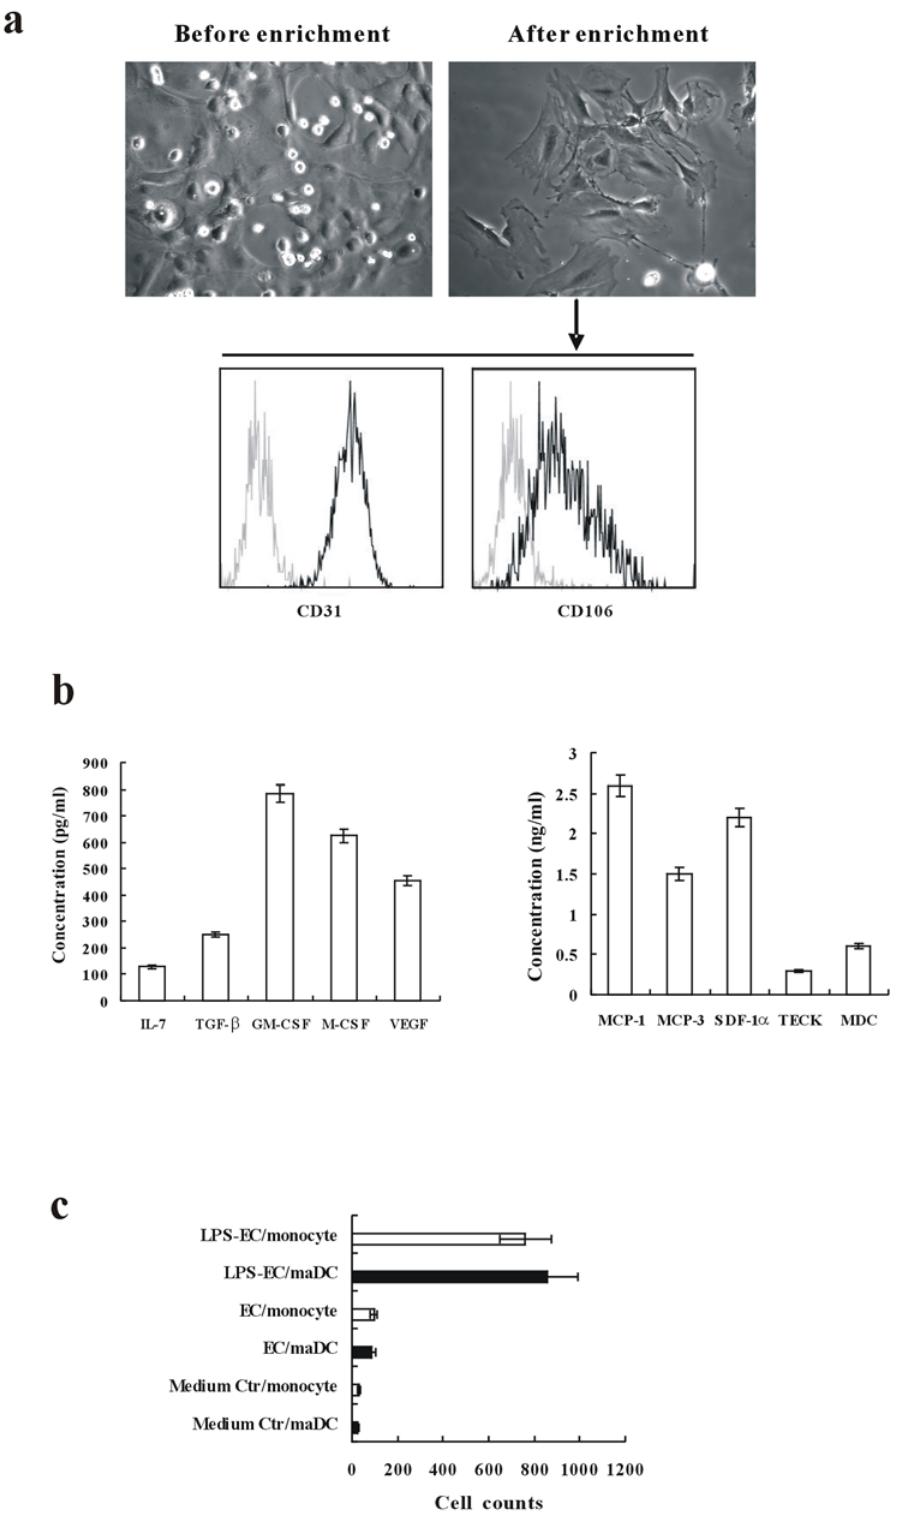
Figure 2. The characteristics of the endothelial cells from the CNS. (a) The CNS endothelial stroma cells before and after CD11b 2 CD31 + selection were observed under the microscopy. The purity of CD11b 2 CD31 + cells was tested by expression of CD31 and CD106. (b, c) The secretion of cytokines including IL-7, TGF- b , GM-CSF, M-CSF and VEGF(b), and chemokines including MCP-1, MCP-3, SDF-1 a , TECK and MDC(c) was detected. (d)The chemotactic ability to monocytes or DCs of the supernatant of LPS-treated EC was assayed.